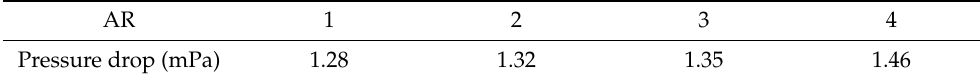
Table 4. The pressure drop for different values of AR.